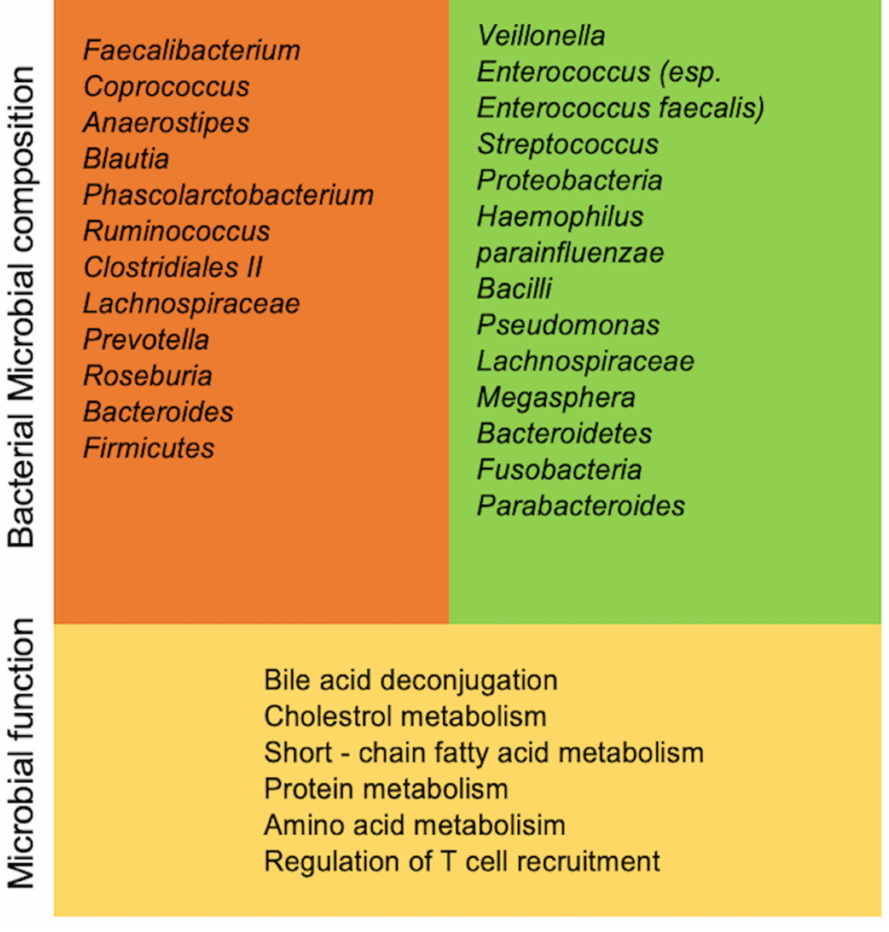
Figure 2. Altered gut microbiota in patients with PSC compared to healthy individuals. Several clinical studies analyzing fecal and mucosal samples have demonstrated that the gut microbiome of individuals with PSC is distinct from that of healthy controls. PSC, primary sclerosing